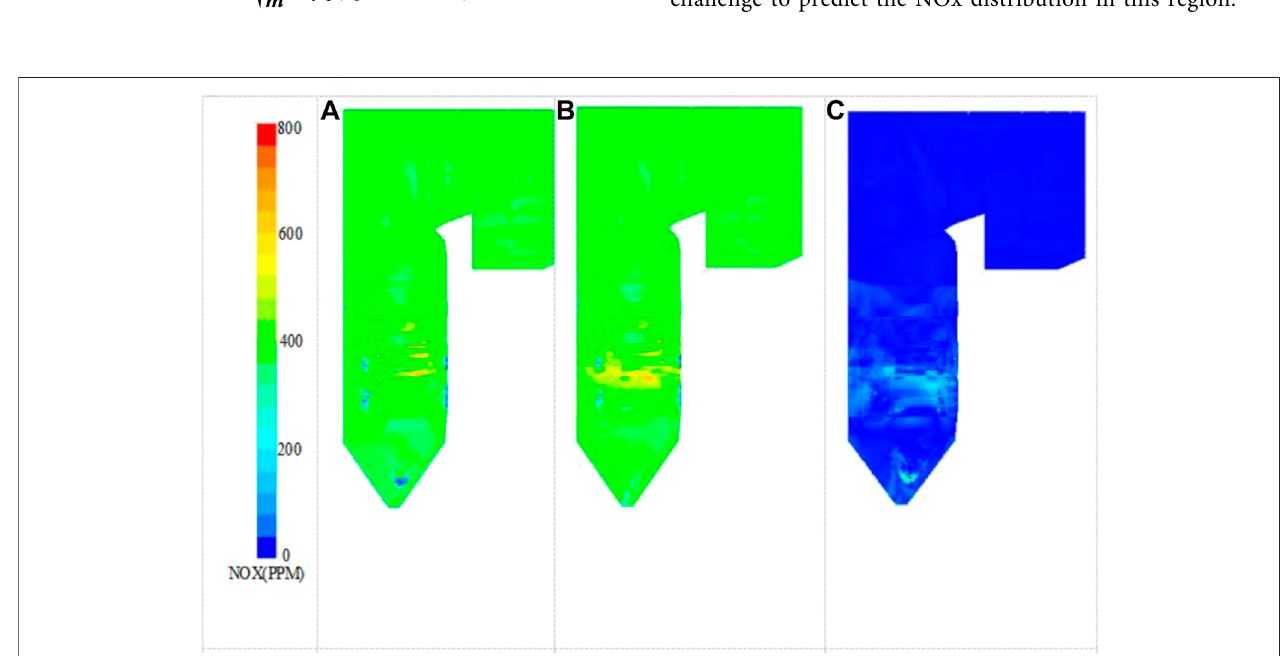
FIGURE 5 | Contour of 3D distribution of NO X . (A) NO X concentration obtained from CFD simulation (B) NO X concentration obtained from ELM prediction (C) Prediction error